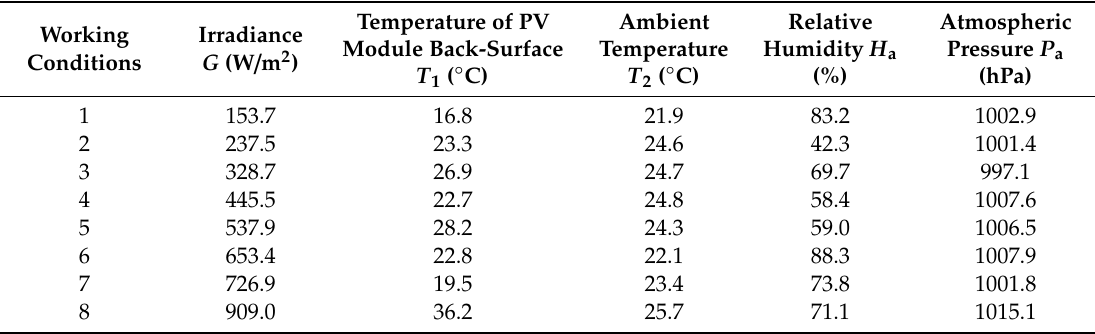
Table 1. The selected working conditions.